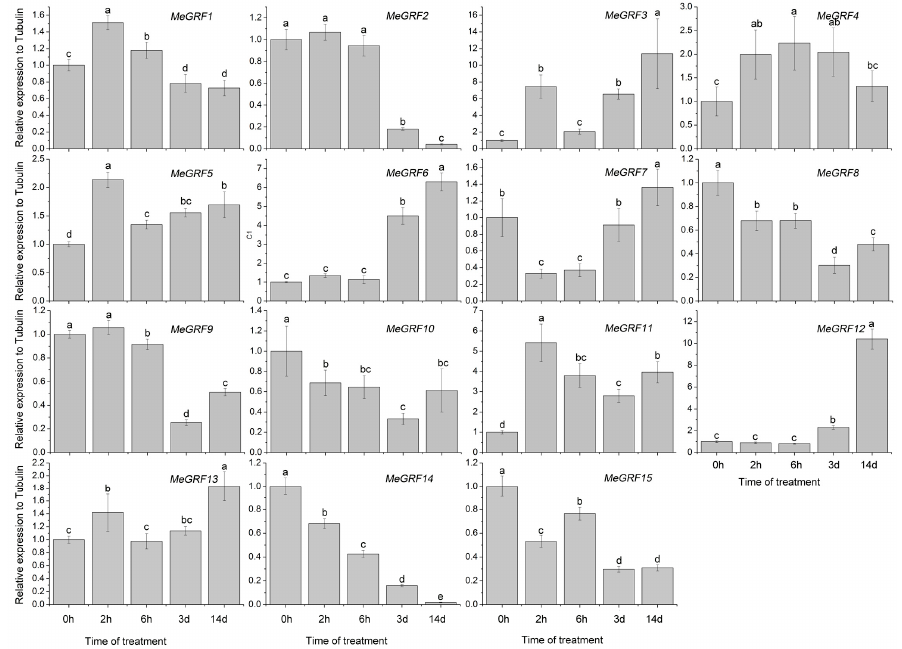
Figure 6. Expression analysis of cassava GRFs in response to salt treatment. The mean fold changes of each gene between treated and control samples at each time point were used to calculate its relative expression levels. NTC indicates no treatment controls (mean value = 1). Data are means ± SD of n = 3 biological experiments. Means denoted by the same letter do not significantly differ at p < 0.05 as determined by Duncan’s multiple range